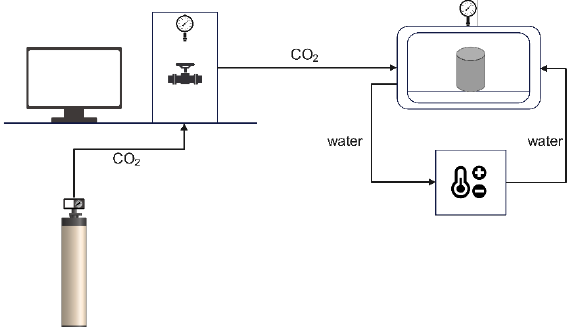
Figure 4. Scheme of the carbonation unit (including CO 2 gas cylinder, computer, pressure vessel).